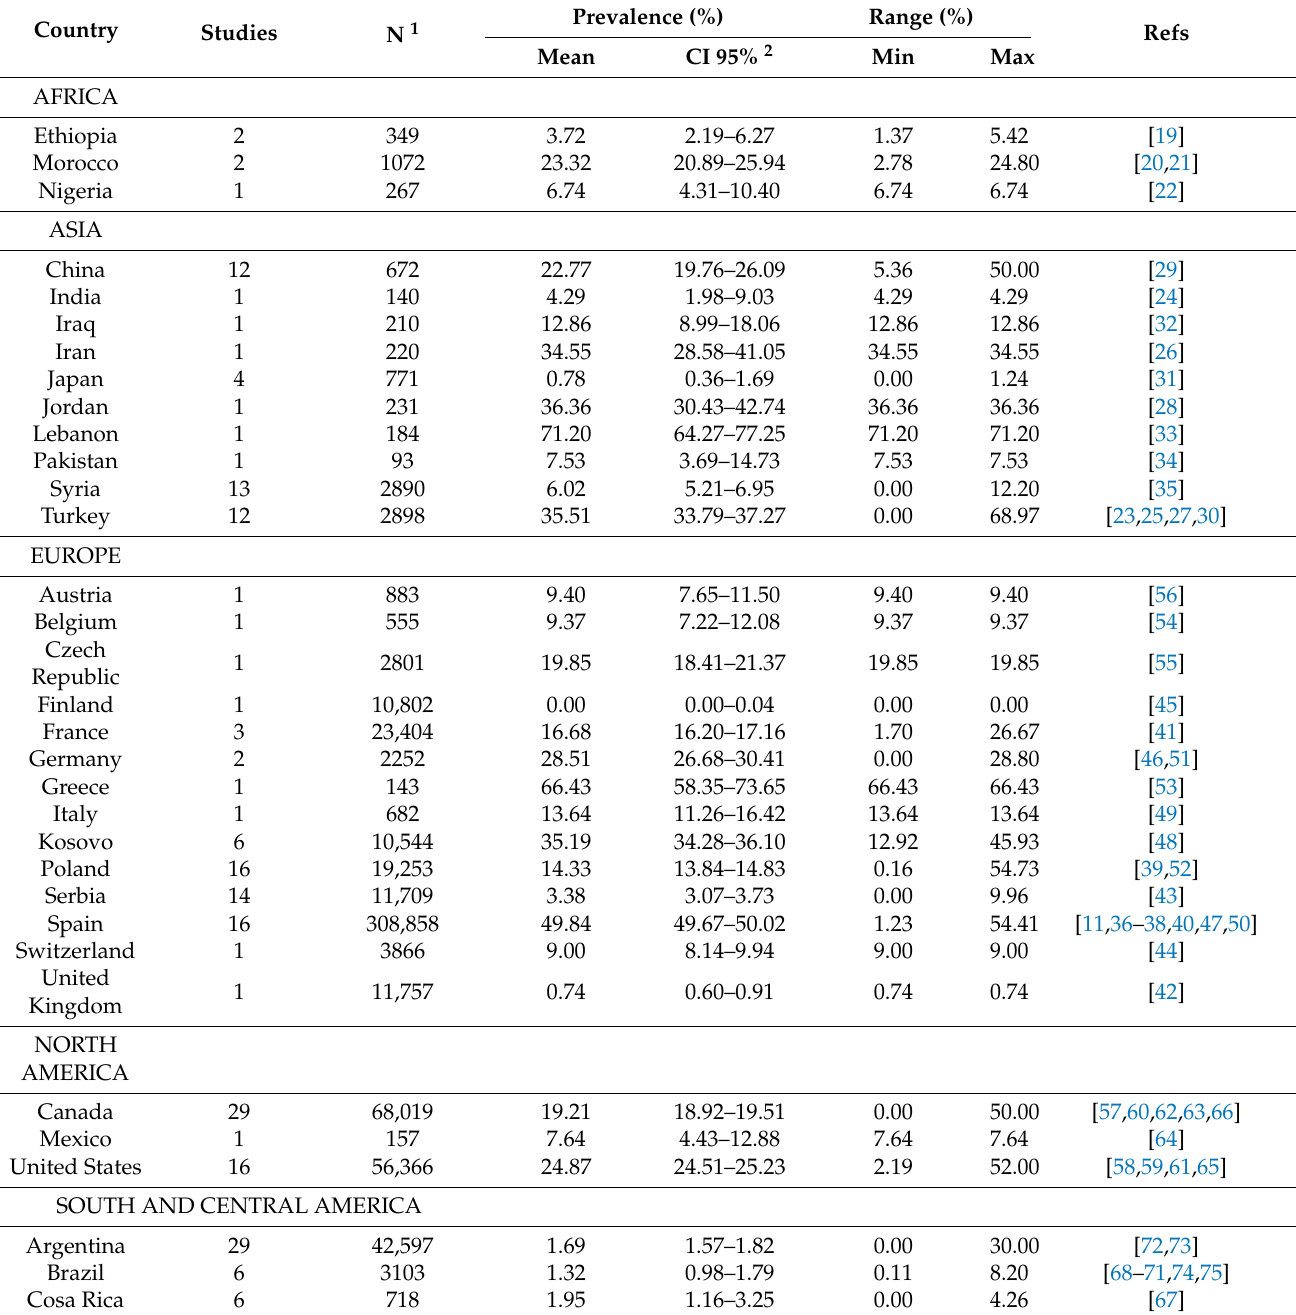
Table A5. Individual SRLV prevalence in each country. Mean, 95% confidence interval, and range are provided. Data extracted from scientific literature published from 1981 to